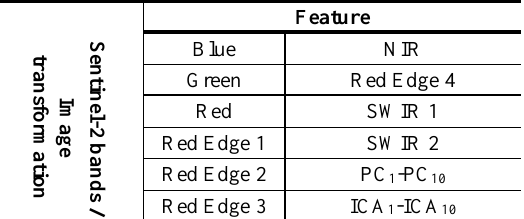
Table 3. Soil salinity features that were extracted from Sentinel-2 satellite data.